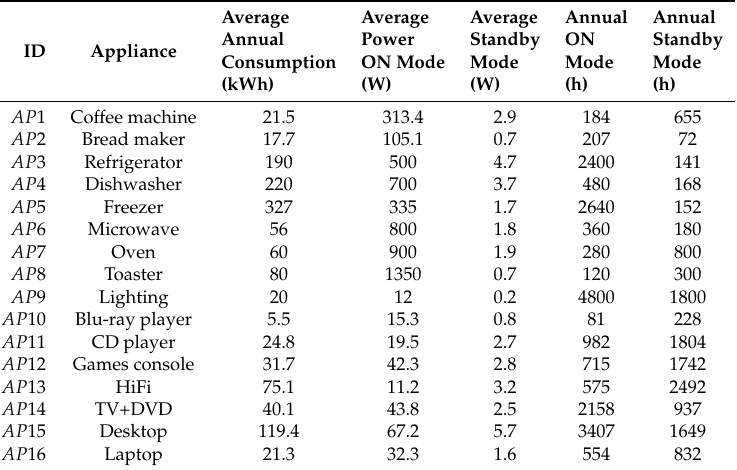
Figure 7. Testbed setting ( a ) and smart switches and the framework’s key devices ( b ). Table 1. Common household appliance energy